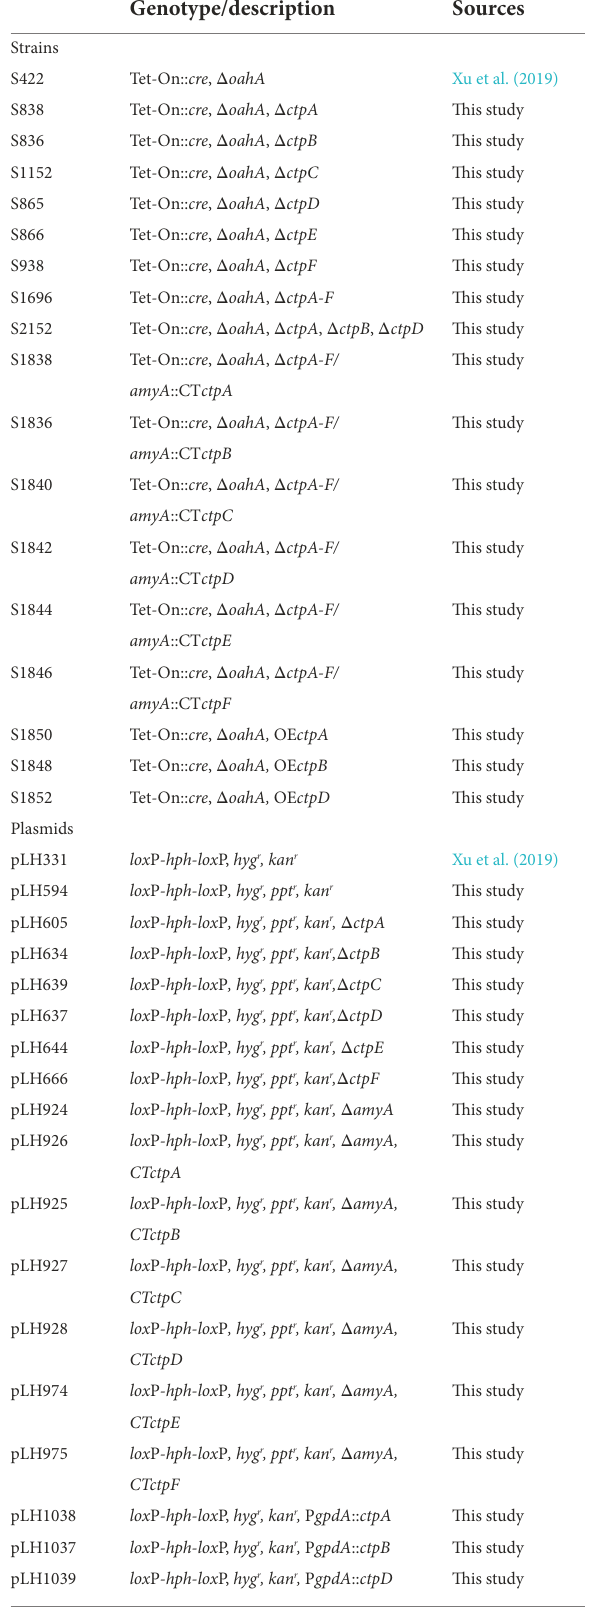
(Table 2). Alignment of candidates was performed with DNAMAN software Version 10. A phylogenetic tree was also established with MEGA software Version 10.1.7 by neighbor- joining statistical method. Accession numbers of the sequences for phylogenetic-tree construction are listed in Supplementary Table